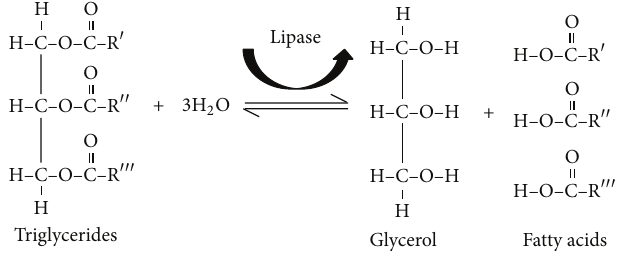
Figure 2: Triglyceride hydrolysis by lipase and its reversible